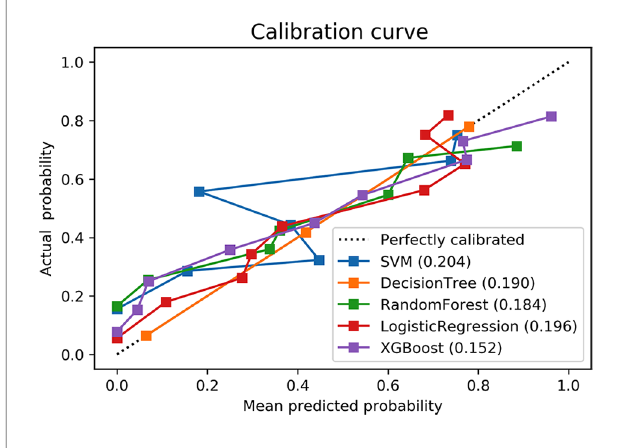
FIGURE 4 Calibration curves of fi ve machine learning models in the validation